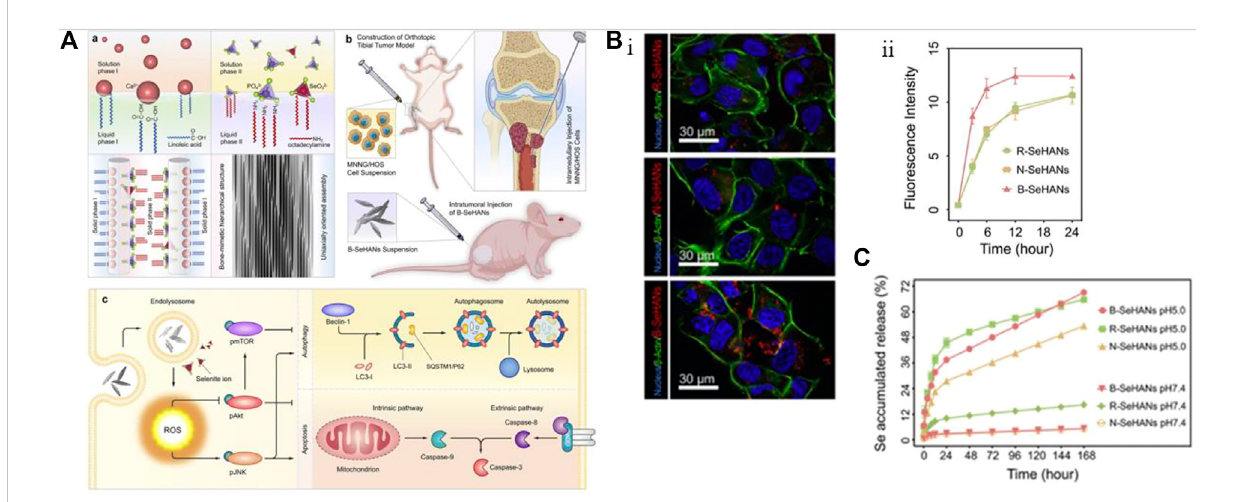
FIGURE 5 Incorporating selenium element into nHAp material to achieve anti-tumor effects. (A) Synthesis method and schematic diagram of anti- osteosarcoma effect of B-SeHANs. (B) The uptake results of B-SeHANs, R-SeHANs, and N-SeHANs by MNNG/HOS cells. After co-cultured for 12 h, the LCSMimagesofthethreeSeHANsinternalizedbyMNNG/HOScells (Bi) ,andtheSeHANuptakebyMNNG/HOScellswasquanti fi edbyFCMandplottedas a curve (Bii) . Compared with non-biomimetic SeHANs, B-SeHANs accumulated more in cells. (C) Compared with R-SeHANs and N-SeHANs, the release kinetics of selenium ions from B-SeHANs showed better acidic reaction characteristics. Reproduced with permission (Li et al., 2020). Copyright 2018, J Biomed